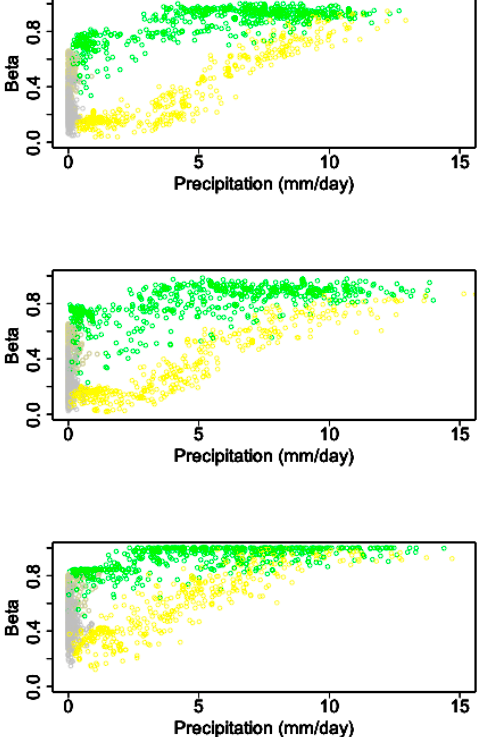
Figure 4. Precipitation versus the JULES beta parameter for (from top to bottom) Chikanta, Magoye, and Makafu for May–September (grey circles), October-December (yellow circles), and January–April (green circles).